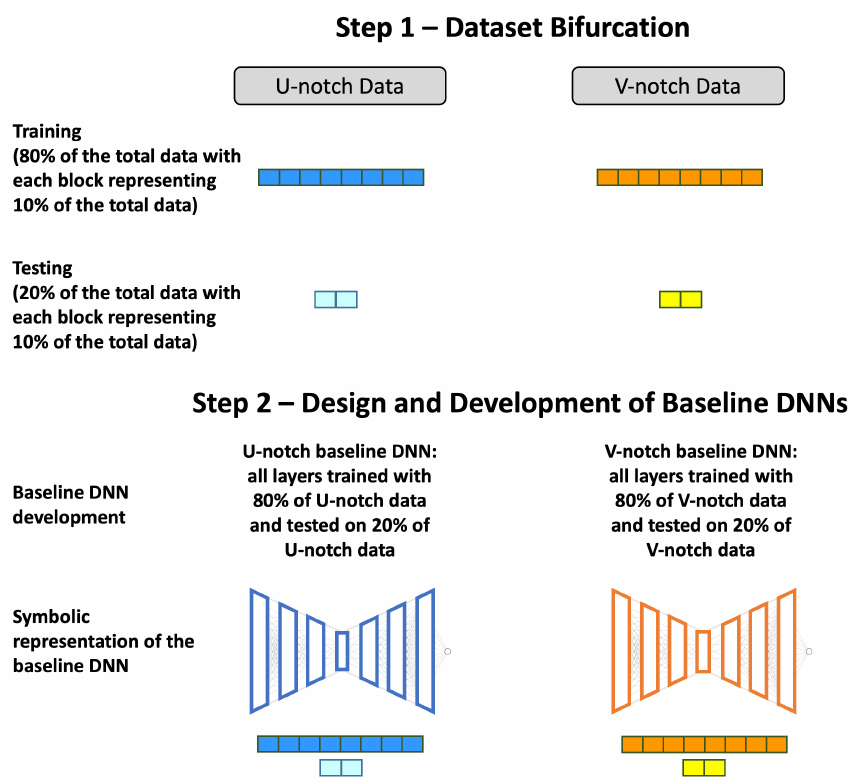
Figure 4. Overview of the data analysis methodology split into two steps: (i) Step 1: dataset bifurcation and (ii) Step 2: design and development of baseline